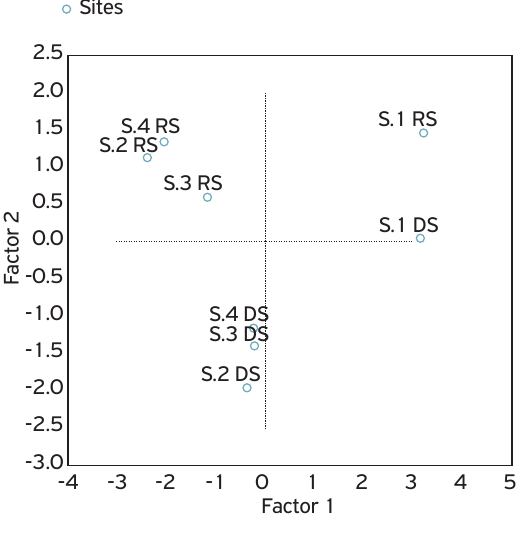
Figure 2. Principal component analysis of the physical-chemical parameters and toxicity in the S.1 as S.4 sites in Atibaia River in dry and rainy seasons